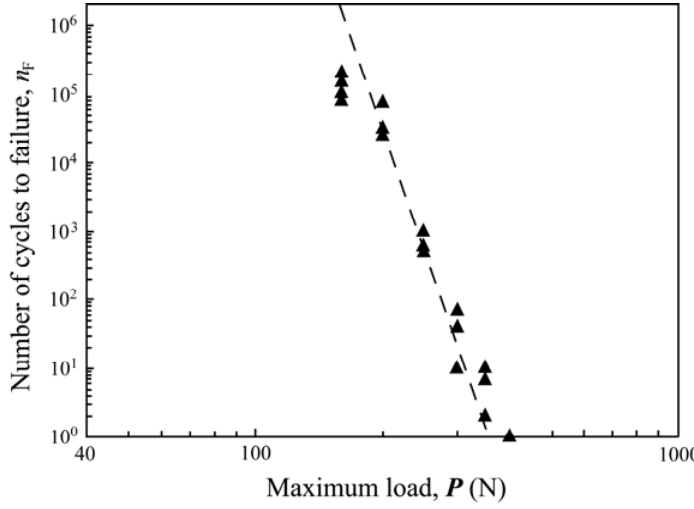
Figure 5. The graph represents a constructed damage map (load-cycles-type of failure) for porcelain/zirconia/composite trilayers subjected to off-axis fatigue loading .Note that for a high biting force (400 N or greater), cone cracks (black triangles) propagate through the entire porcelain veneers at first cycle. However, for a relatively low biting force (100–140 N), it takes several million cycles to propagate the cone cracks from the occlusal surface to the veneer/core